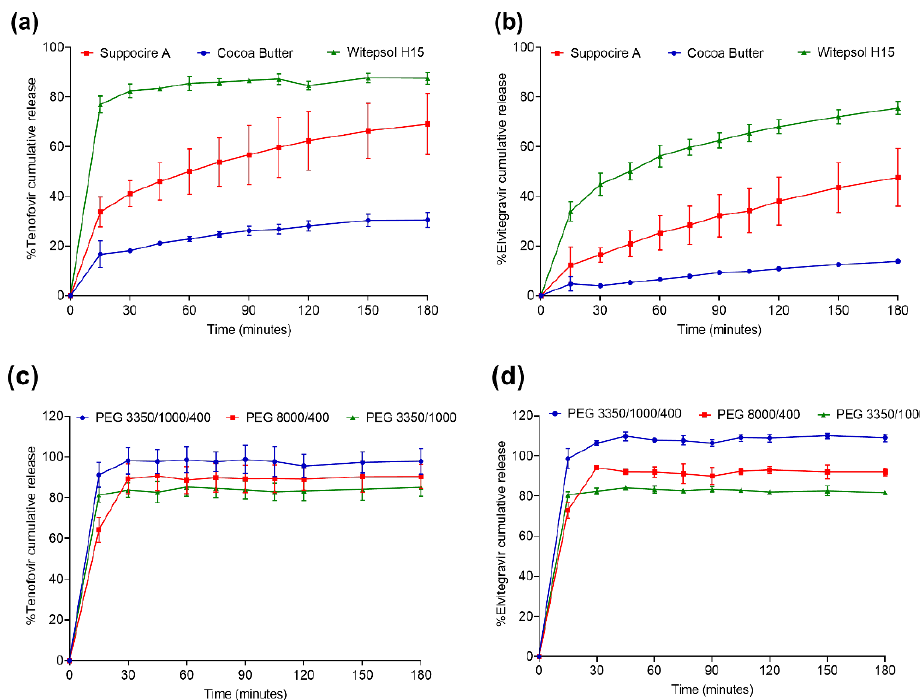
Figure 1. In vitro dissolution of tenofovir ( a – c ) and elvitegravir ( b – d ) from suppositories with three fat-soluble bases ( a , b ) and three PEG bases ( c , d ).